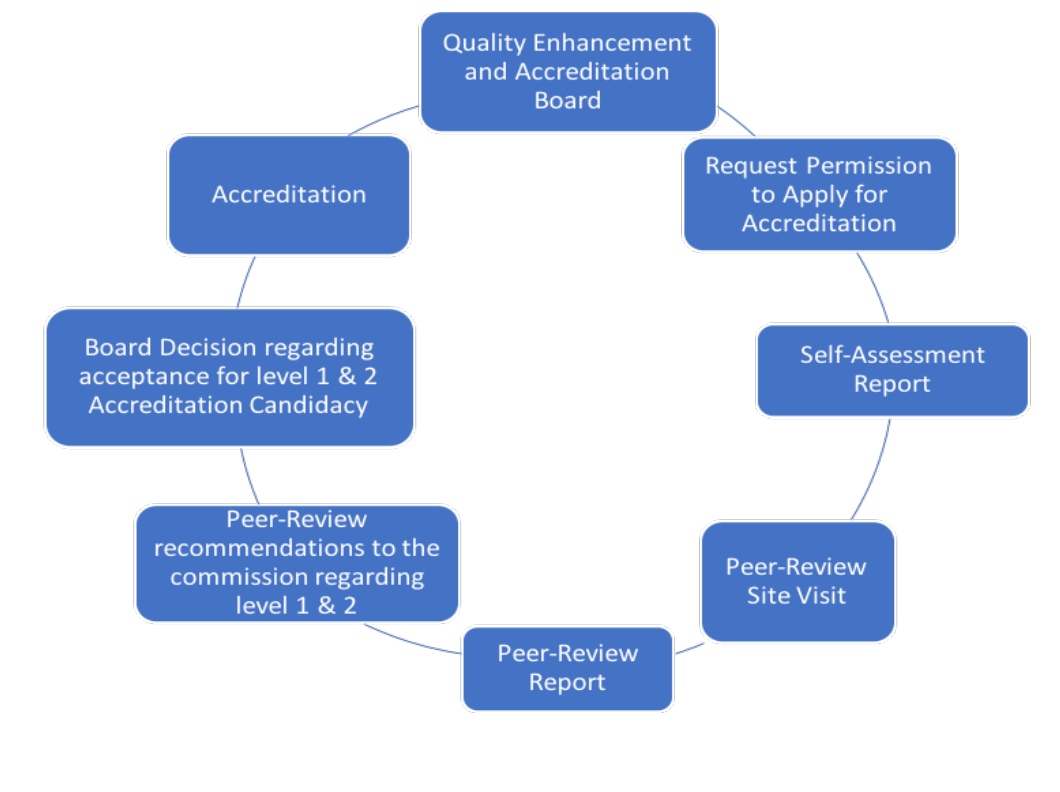
Figure 7. Afghanistan QAA process model